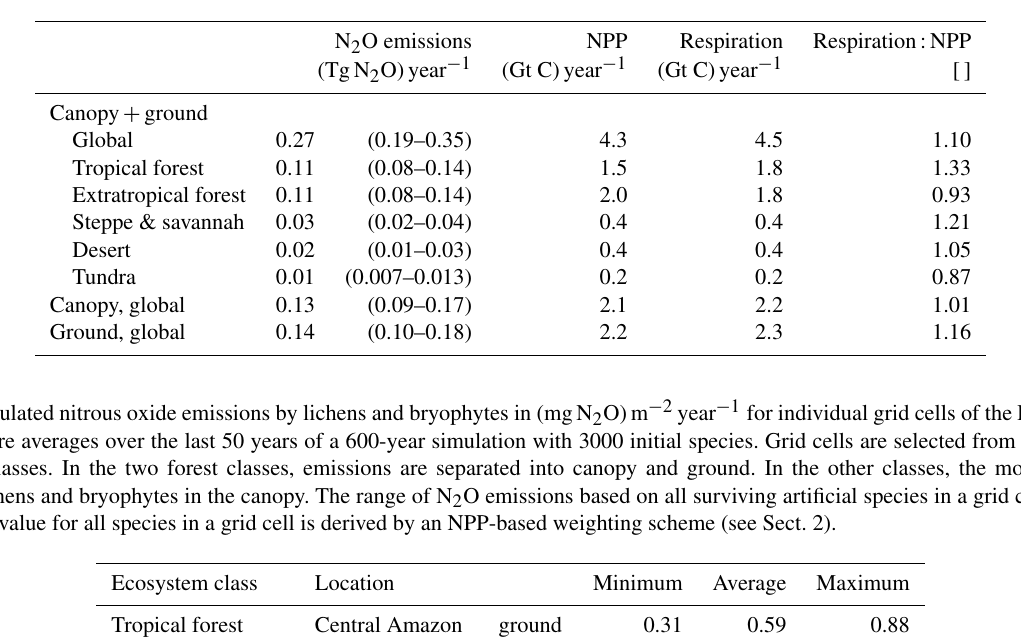
Table 1. Annual global total values of N 2 O emissions, NPP, respiration and the ratio of respiration to NPP estimated by LiBry and separated into lichens and bryophytes living in the canopy and on the ground. The values in brackets in the first column show the uncertainty in N 2 O emissions due to the conversion of released CO 2 to N 2 O (90% confidence interval from Lenhart et al. (2015)). Ecosystem classes shown are based on the categories made by Olson et al. (2001), which were aggregated by us in the same way as in Elbert et al. (2012). “Gt C” stands for gigatons of carbon.